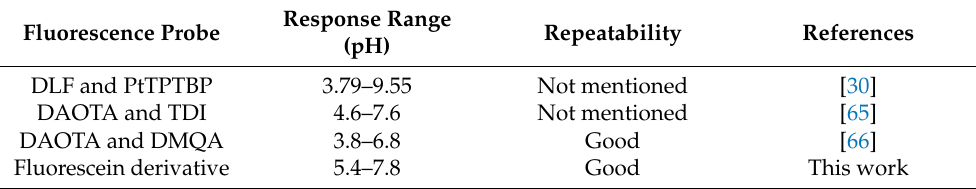
Table 2. Comparison of the proposed sensor with other pH detection